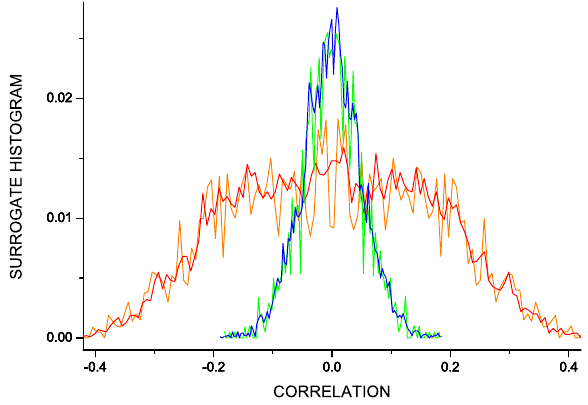
Fig. 6. Histograms of cross-correlations of independent FT (green and orange lines) and amplitude-adjusted FT (red and blue lines) surrogate data for SATA of a pair of nodes from the low entropy rate area (orange and red lines, nodes with the latitude 0 ◦ , longitude 90 ◦ W and 10 ◦ S, 120 ◦ W) and a pair from the high entropy rate area (green and blue lines, nodes 60 ◦ N, 25 ◦ E and 60 ◦ N, 75 ◦